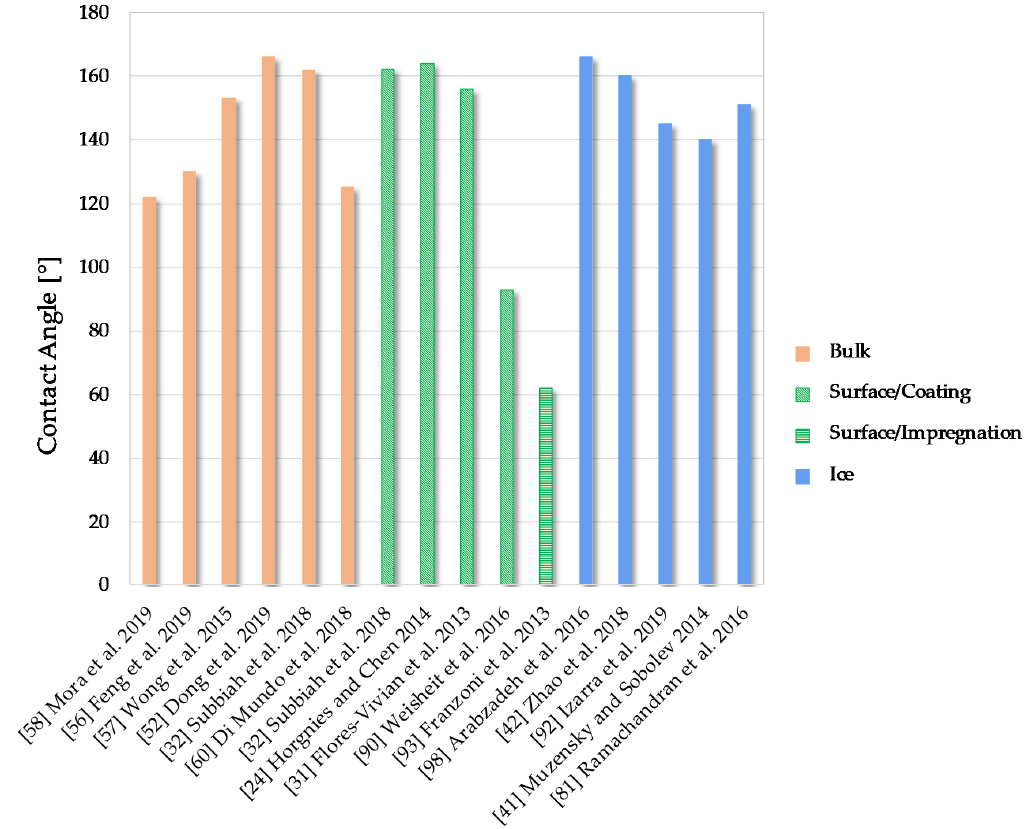
Figure 18. Review on CA values reported in the literature about hydrophobic modifications on concrete.